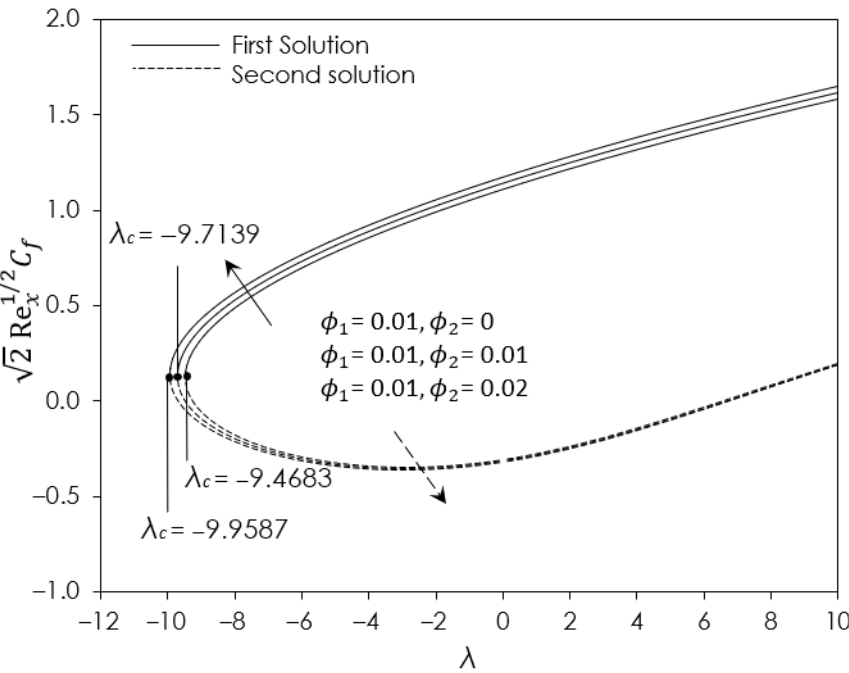
√ Figure 2. Variation of √2 Re 𝑥1/2 𝐶 𝑓 for different values of 𝜙 2 . Figure 2. Variation of 2 Re 1/2 x C f for different values of φ 2 . Figure 4 delineates the magnetic parameter M impact on